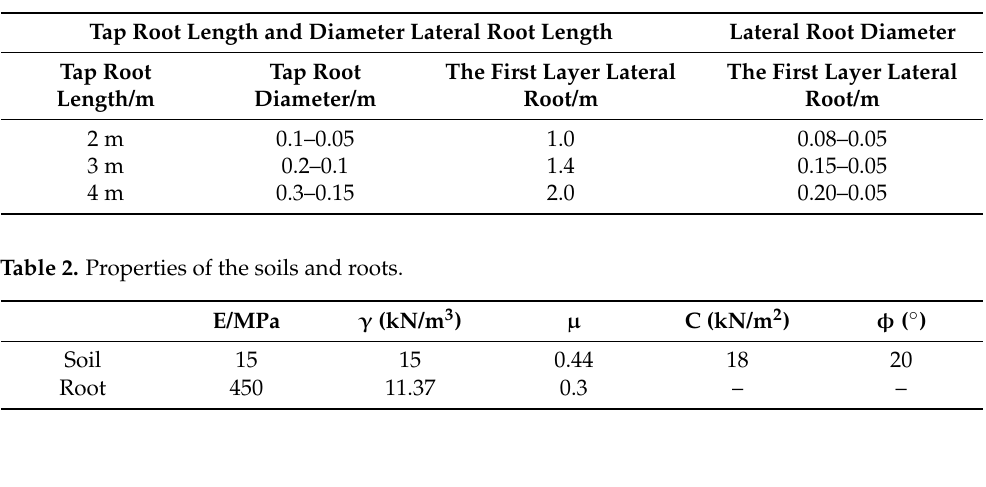
Table 2. Properties of the soils and roots.